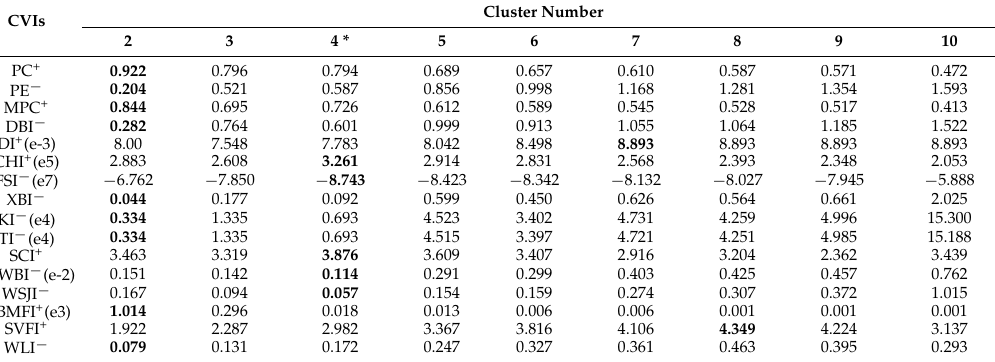
Table 3. Variations of the 16 CVIs with cluster numbers ranging from 2 to 10 for the QuickBird image. Table 4. Variations of the 16 CVIs with cluster numbers ranging from 2 to 10 for the Landsat TM